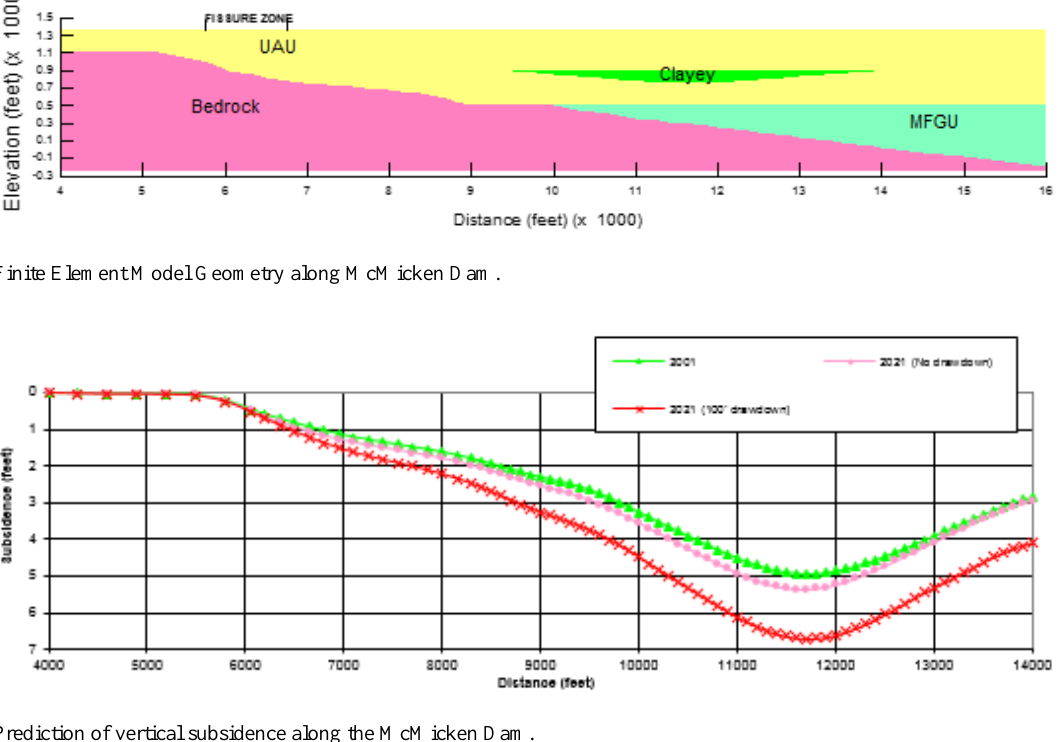
Figure 2. Prediction of vertical subsidence along the McMicken